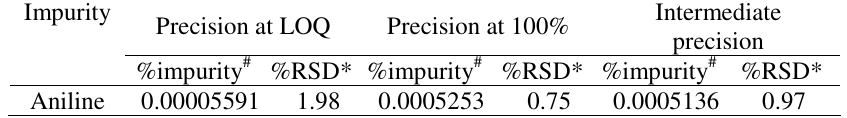
Table 2. Precision at LOQ, precision at 100% and intermediate precision results @